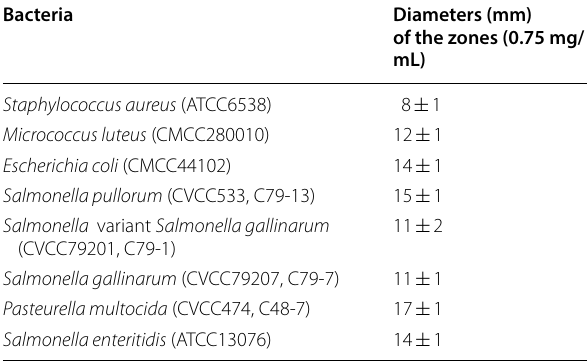
Table 1 Diameters (mm) of the zones of inhibition of growth of all probed